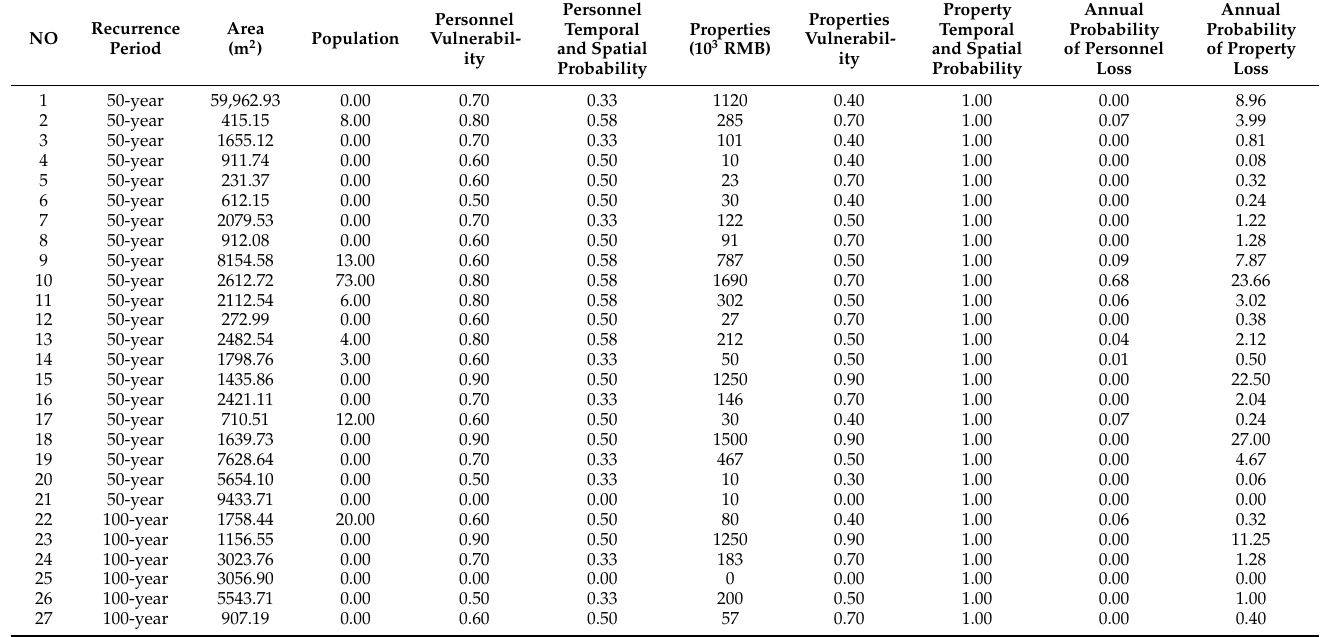
Table 8. Annual probability of personnel loss and property loss of all 27